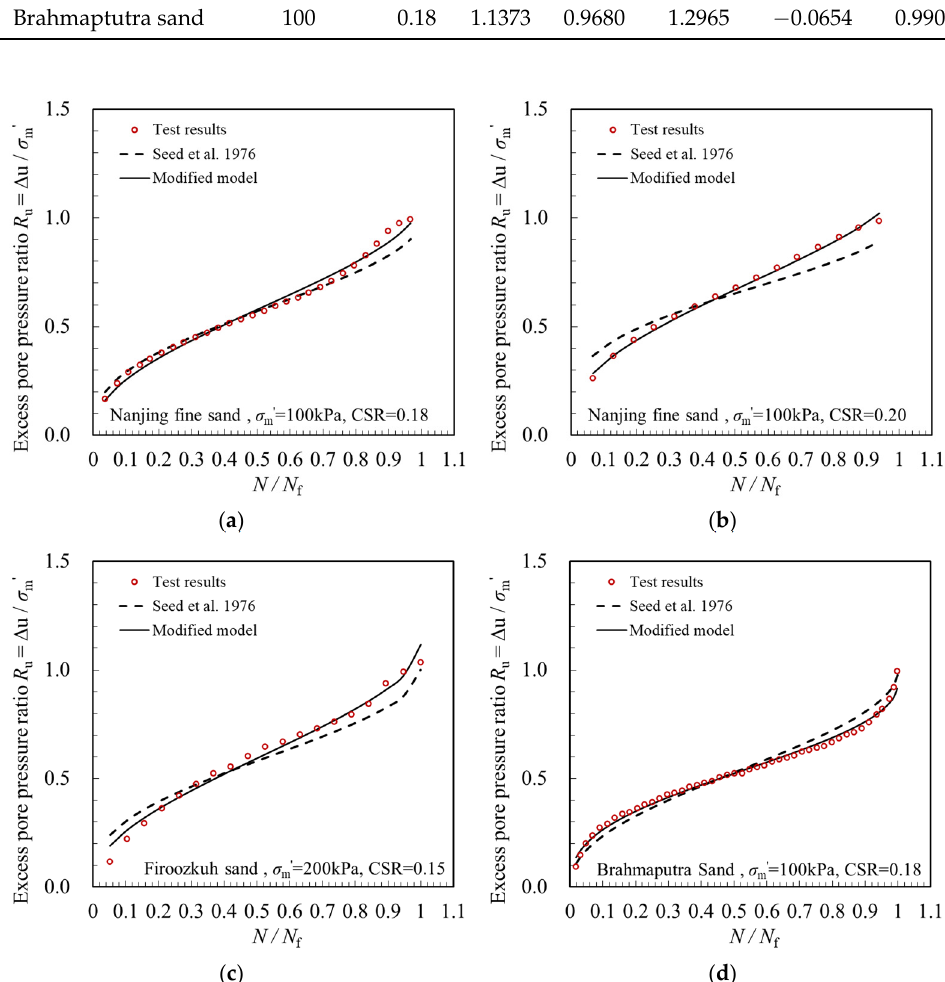
Figure 13. Excess pore water pressure data from Wang et al. [47], ghadr et al. [48] and Kumar et al. [49] and fitting curves of the two models: ( a ) Nanjing fine sand, σ m ’ = 100 kPa, CSR = 0.18; ( b ) Nanjing fine sand, σ m ’ = 100 kPa, CSR = 0.20; ( c ) Firoozkuh sand, σ m ’ = 200 kPa, CSR = 0.15; ( d ) Brahmaptutra sand, σ m ’ = 100 kPa, CSR = 0.18.